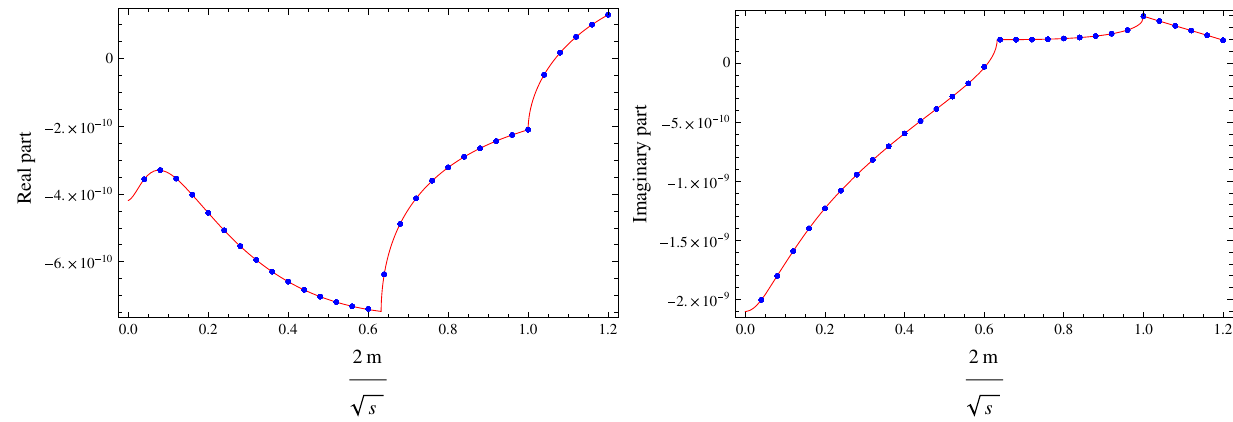
Fig. 8 Mass scan of a box integral. The red curve is done with LoopTools and the blue points are obtained with the LTD method Table 3 Sample scalar pentagons